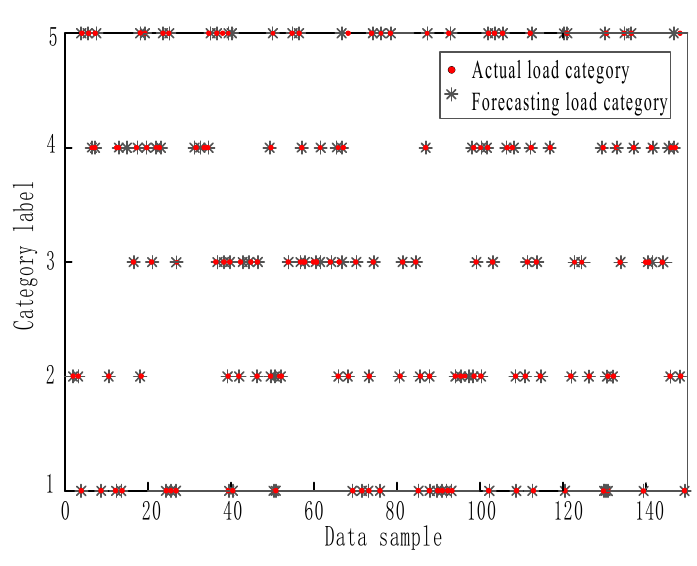
Figure 7. Prediction effect of BP network.